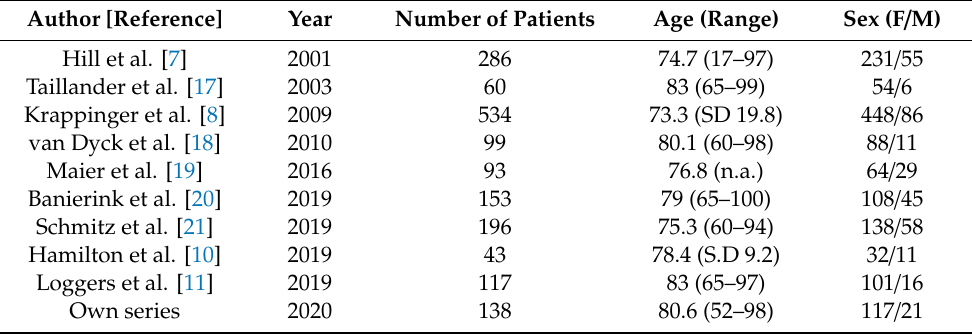
Table 2. Age and sex of patients with pubic ramus fractures in previous